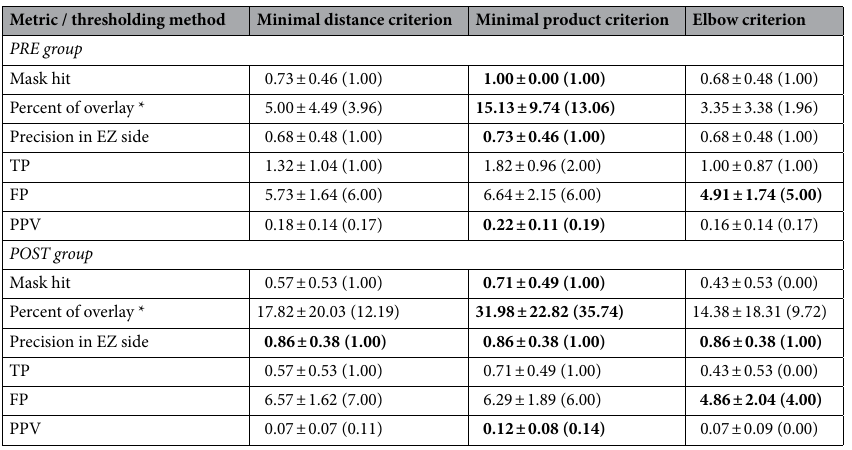
Table 1. Evaluation of particular metrics in proposed thresholding methods. The values are mean ± standard deviation (median). The optimal values are marked in bold. In TP itself, there might not be a clear optimal value in all cases. Therefore we did not mark any TP value in bold. Used abbreviations: TP—true positive, FP— false positive, PPV—positive predictive value, EZ—epileptogenic zone, POST—postoperative group, PRE— preoperative group, *percent of overlay of the resection mask/ EZ hypothesis mask by the most precise